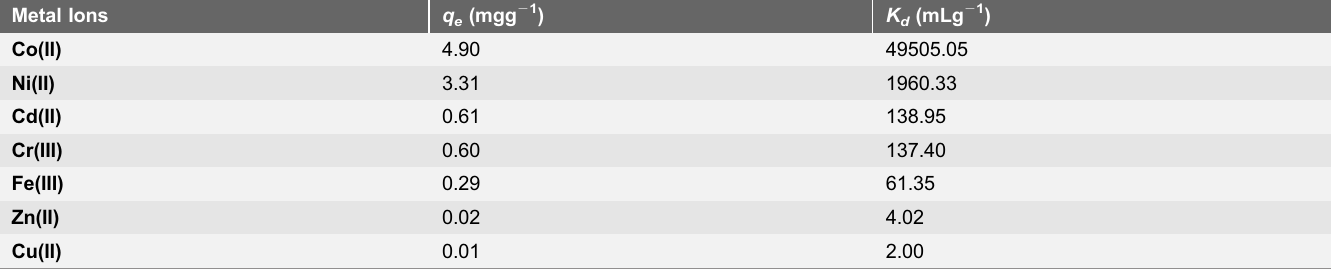
Table 1. Selectivity study of the adsorption of Ag 2 O 3 -ZnO NCs phase toward different metal ions at pH 5.0 and 25 ˚ C ( N 5 3). Metal